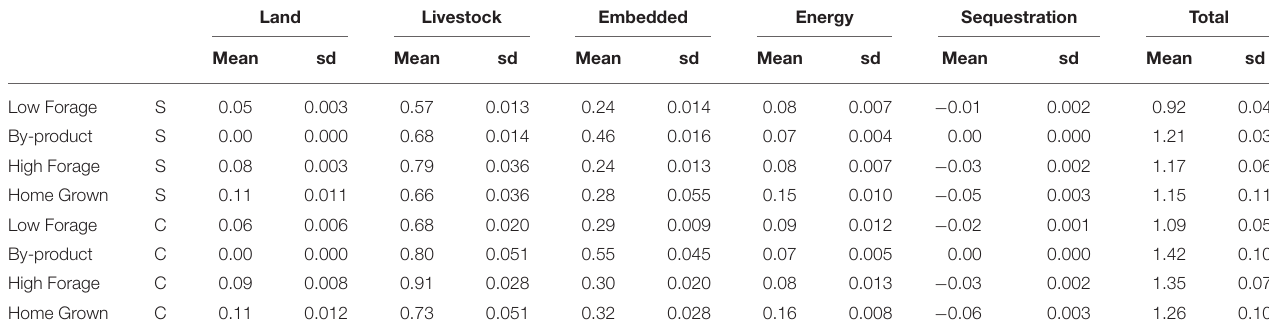
FIGURE 2 | Box plots for Select and Control merits showing economic allocation dairy system emissions with effect of NCGD and CP variation in the ration.